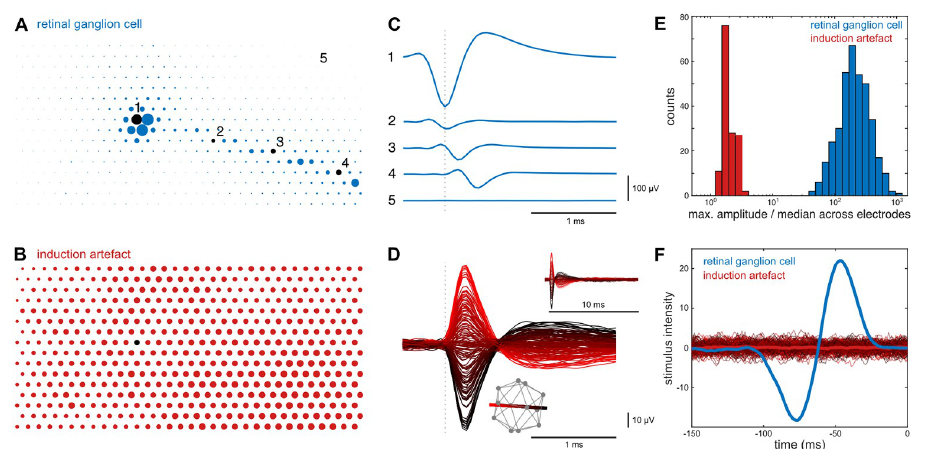
Fig 6. Rapid transitions of the magnetic field induce distinct electrical artifacts in the recording equipment. Multi-electrode array recording of quail retinal ganglion cells. A: Representation of the signal strength of a ganglion cell spike across the 512 electrodes of a multielectrode array. Dot size represents absolute signal amplitude. For visual clarity, maximal amplitudes are shown smaller than to scale. B : As A for an induction artifact. The black dot corresponds to position 1 in A. C: Average spike waveform on five electrodes marked in A. Note the strong signal at the cell soma location (1) and the increasing delay of the signal on the electrodes along the axon (2–4). D: Temporal induction artifact on electrode 1 as in C for 12 � 12 magnetic field transitions. Dashed line indicates the time of field transition. Bottom inset illustrates the icosahedron of the 12 used magnetic field vectors. The red-to-black line represents the axis with the strongest inductive effect and is used as the color map. Top inset: The same induction artifact at a longer time scale. E: Biological spikes (blue, n = 367 quail retinal ganglion cells) and induction artifacts (red, n = 144) have different spatiotemporal waveforms. Note logarithmic binning. F: Event-triggered average visual stimulus for spikes of the neuron in A (blue) and all magnetic field transitions (color map as in D). Thick red line: mean over all field transitions. Triggered average stimulus confirmed a clean classification with a normal light ON response for the neuron in A and no correlation between the visual stimulus and the induction artifacts, as expected.